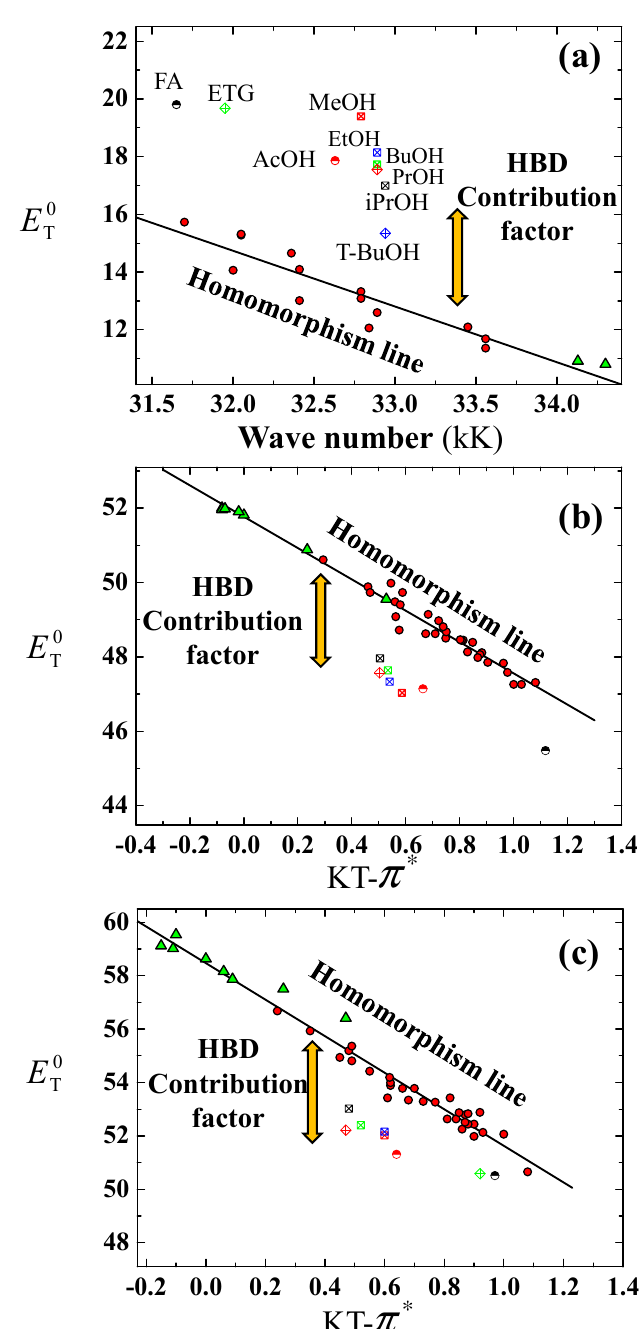
E , , kcal · mol − 1 ) T T